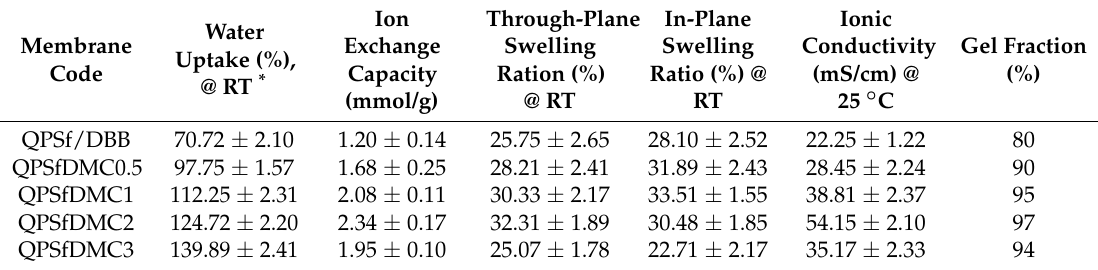
Figure 4. Water uptake with temperature for the different membranes. Table 1. Properties of the membranes.